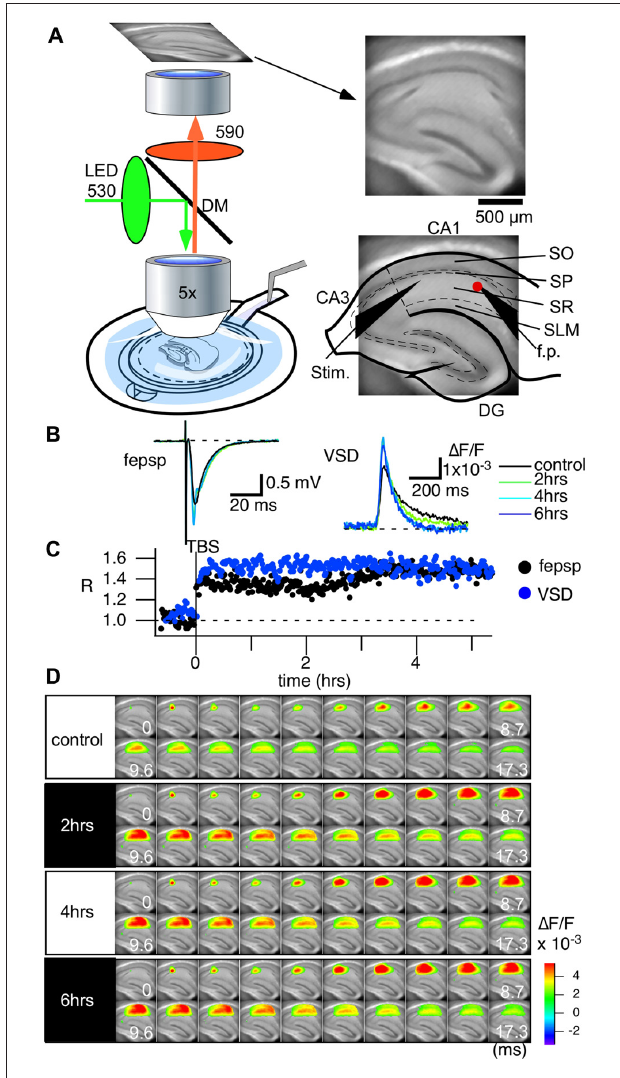
FIGURE 2 | Voltage-sensitive dye (VSD) imaging can follow the long-term circuit activity changes of hippocampal slices caused by theta-burst stimulation (TBS). (A) An illustration showing the recording setup of the optical recording system. A membrane filter attached to a thin plastic ring holds a slice preparation. The ring is then held in place with a recording chamber, in which adequate ACSF is provided from the bottom of the experimental chamber and flows over the slice towards the outlet tubing. A water immersion objective lens (5 × Olympus, NA 0.35) of a tandem-lens configured epifluorescent optics unit is placed above the slice preparation. An imaging device (MiCAM Ultima and MiCAM02, Brainvision Inc., Tokyo, Japan) captures the fluorescent images of the slice (right). The configuration of the electrodes (Stim., the stimulation electrode; f.p., the field potential electrode) and an illustration of the hippocampus are superimposed. Abbreviations: SO, stratum oriens-alveus; SP, stratum pyramidale; SR, stratum radiatum; SLM, stratum lacunosum-moleculare. (B) Traces of field excitatory postsynaptic potentials (fEPSPs) recorded with the field electrode before and after TBS-induced long-term potentiation (LTP) and the optical signal at the corresponding pixel. Both traces are average of eight traces. (C) Time course of LTP with the fEPSP slope (black) and the optical signal (blue) at the tip of the field potential electrode. (D) The panel shows consecutive images of the response for the control recording and for recordings made at 2 h, 4 h and 6 h. We recorded the optical signals every 60 s at a frame rate of 0.1